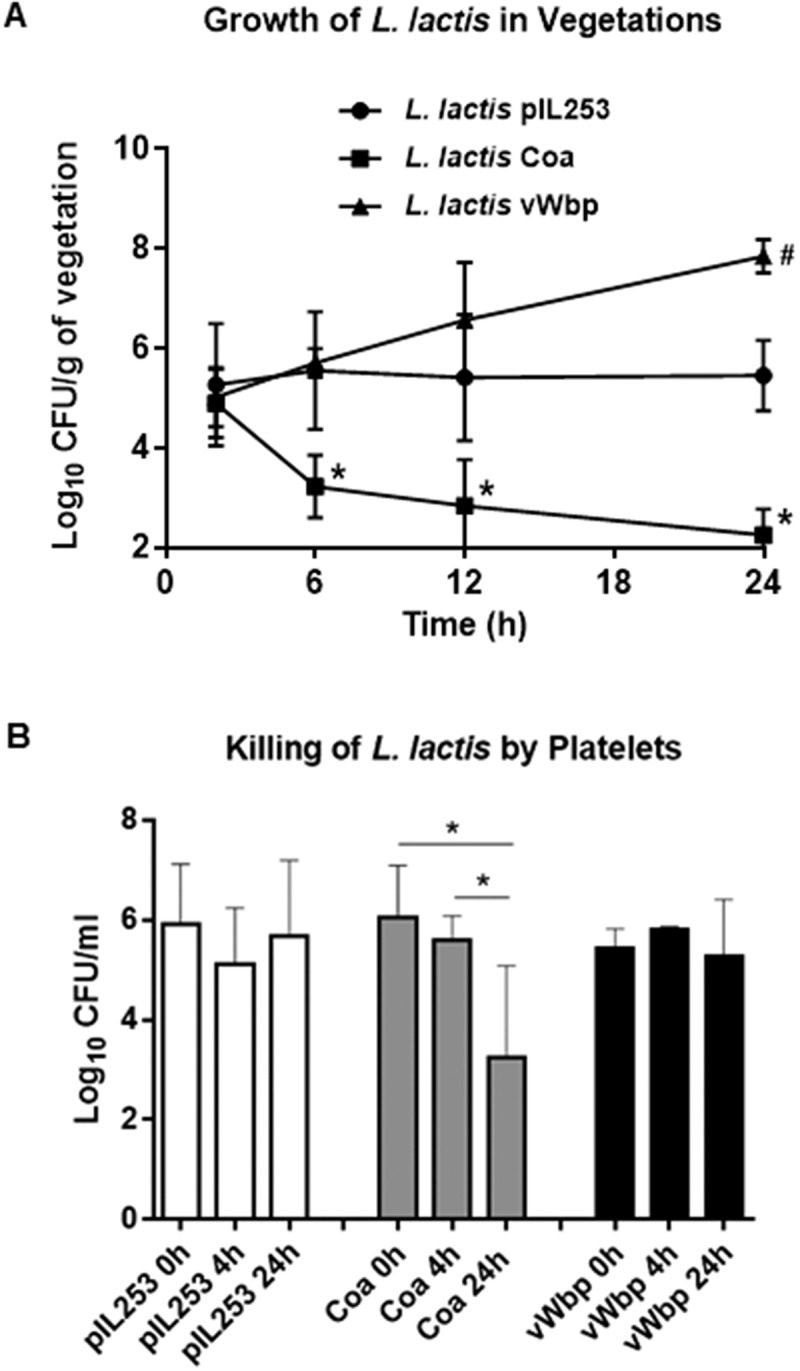
Evolution of vegetation infection after challenge with parent L. lactis pIL253 and recombinant L. lactis Coa or L. lactis vWbp (a) and in vitro killing by platelets (b). (a) Groups of 6–10 rats were inoculated with of 107 CFU and sacrificed at various times after challenge. Data represent mean ± SD of vegetation bacterial titres. *, P < 0.01 vs L. lactis pIL253 and L. lactis vWbp; #
P < 0.01 vs L. lactis pIL253, as compared by the one-way ANOVA followed by Tukey’s multiple comparisons test. (b) Killing of L. lactis by platelets after 4 and 24 h of exposure. *, P < 0.05 by one-way ANOVA followed by Tukey’s multiple comparisons test.